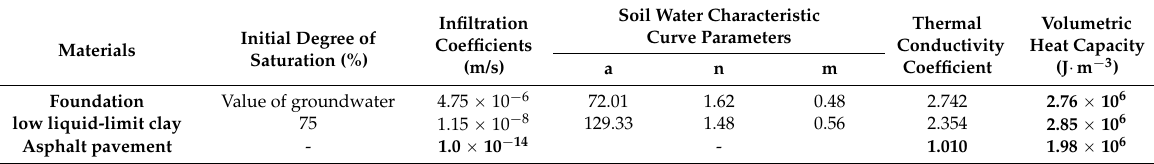
Table 4. Hydraulic and thermal property parameters of subgrade soil.